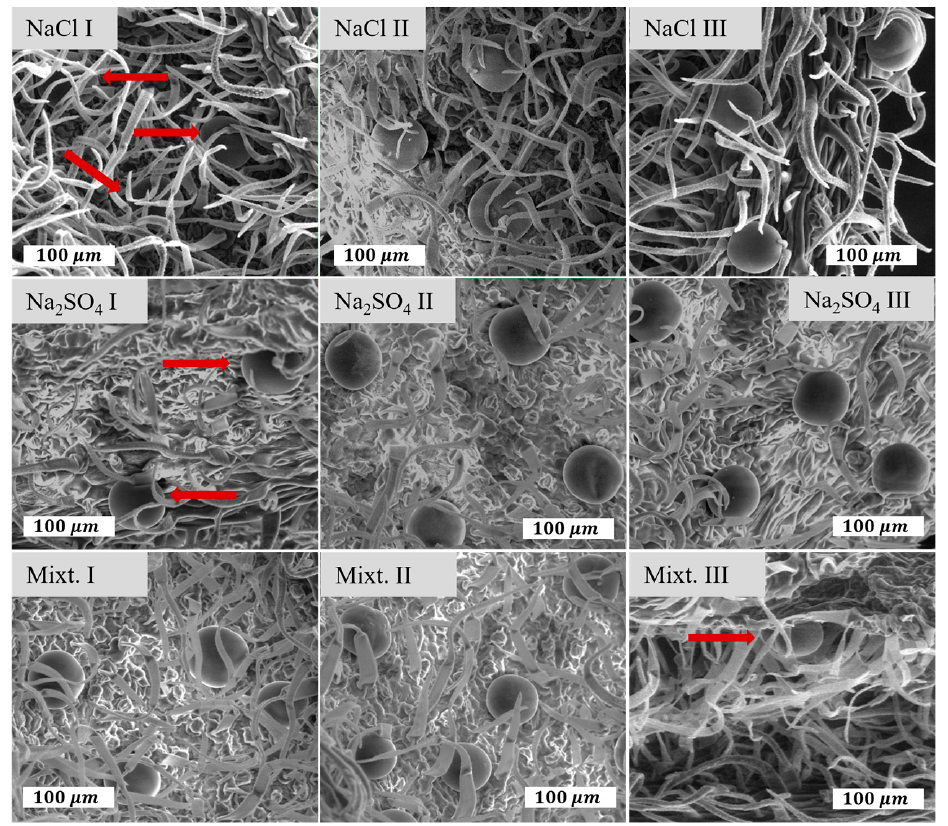
Figure 2. ESEM microimaging of the surface of leaves with the identification of the granular trichomes for all variants.